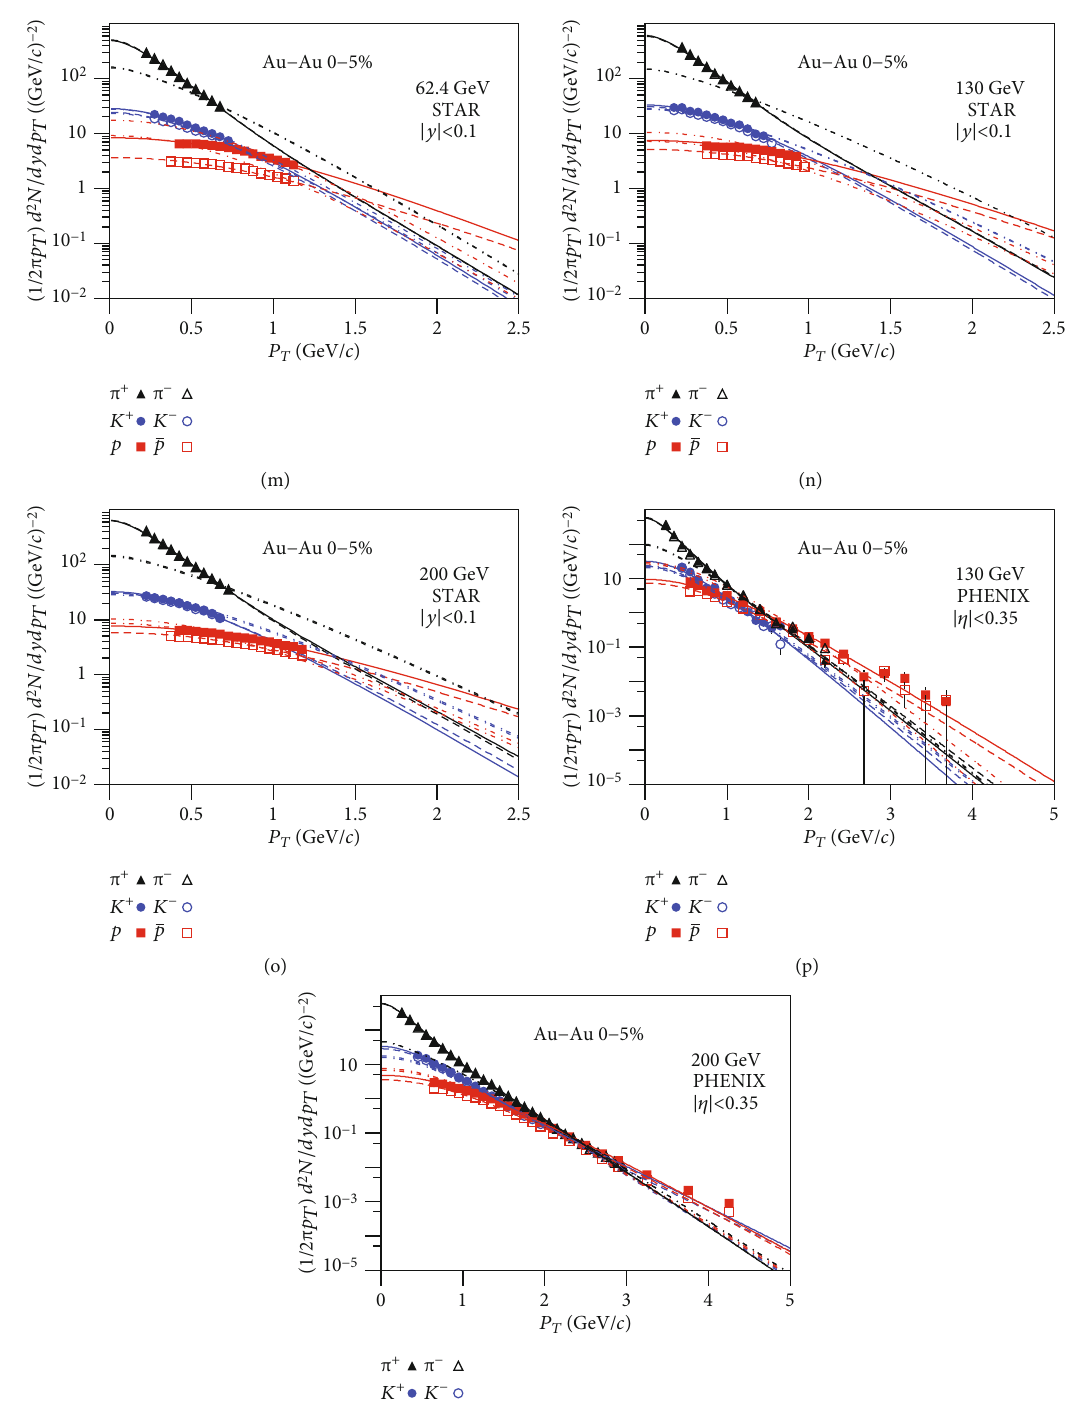
m − m ð 1/2 π p Þ · d 2 N / dydp ð 1/2 π m Þ · d 2 N / dydm π + , π − , K + , K − , p , and (cid:1) p produced at mid- y or mid- η in Figure 1: The p T 0 ) spectra, T T ], of ffiffiffiffiffiffiffiffi p T ( T T [ s central Au-Au collisions at high . The closed and open symbols represent, respectively, the experimental data of positively and negatively NN charged particles measured by (a – e) the E866 [25] and E895 [26, 27], (f) the E802 [28, 29], (g – o) the STAR [30 – 32], and (p – q) the PHENIX [33, 34]. Collaborations marked in the panels which appear mostly (g – q), where in (a) – (d), the data for π ± and K + are taken from the E866 Collaboration [25] and the data for p are taken from the E895 Collaboration [26, 27]. The solid and dashed curves are our results fi tted by Equation (6) or (7) for positively and negatively charged particles, respectively. The dot-dashed curves are our results fi tted by using the weighted average parameter h T i . The dotted curves and asterisks in (a) – (f) represent the MC results for K + with high ( 10 6 particles) and low ( 10 4 particles) statistics,